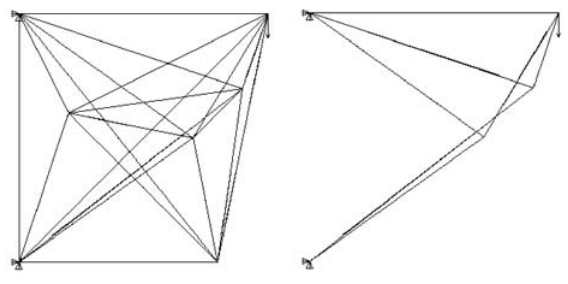
Fig. 2. Possible connections in the 5-node truss system × × There is 5 4 0.5=10 maximum possible number of